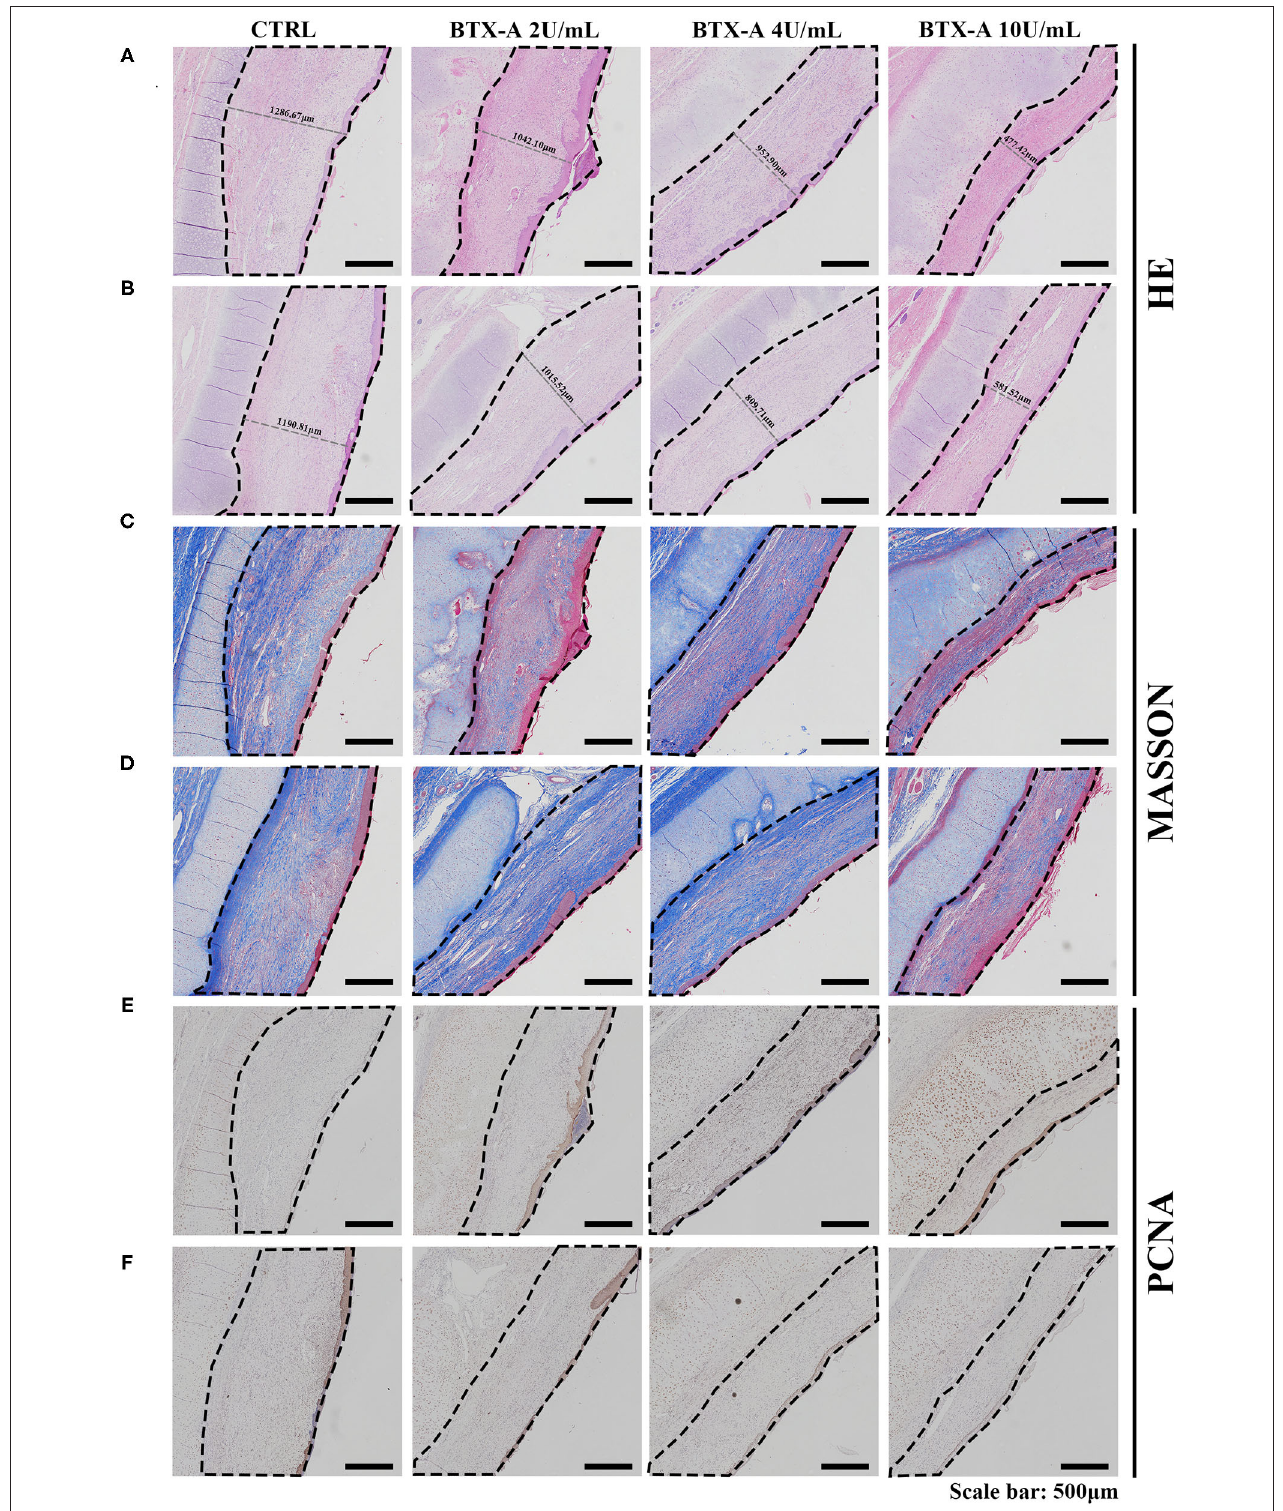
FIGURE 8 | Results at 3 weeks after the treatment. The scar tissues were marked with dotted lines. (A) HE staining of different treated scar samples in the SP overexpression group; (B) HE staining of different treated scar samples in the SP normal-expression group; (C) Masson trichrome staining of different treated scar samples in the SP overexpression group; (D) Masson trichrome staining of different treated scar samples in the SP normal-expression group; (E) PCNA of different treated scar samples in the SP overexpression group; (F) PCNA of different treated scar samples in the SP normal-expression group.